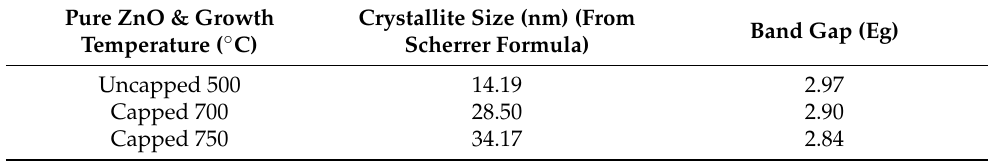
Table 1. Variation in crystallite size and energy band gap of pure and capped ZnO at different temperatures. Pure ZnO & Growth